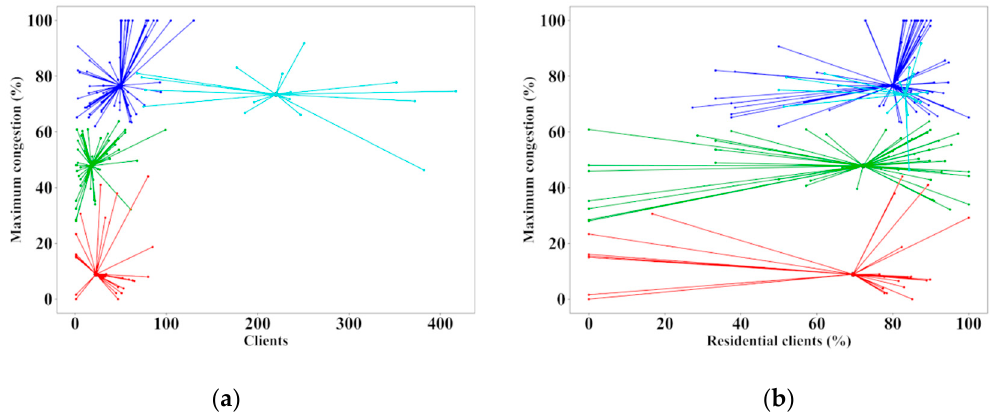
Figure 9. ( a ) Maximum congestion in relation to the number of clients and ( b ) in relation to the proportion of residential clients in the case study.